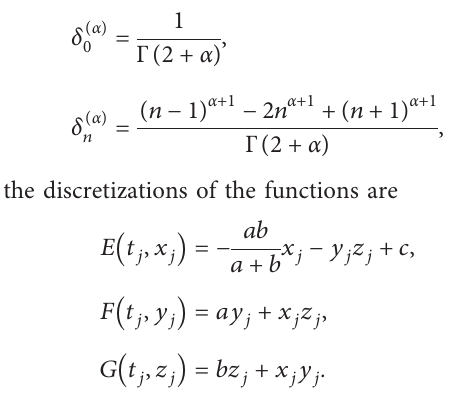
Figure 1: Dynamics of Lu et al.’s fractional-order system in (13)–(15) with the order α � 0 . 92, in context of x , y , and z directions.